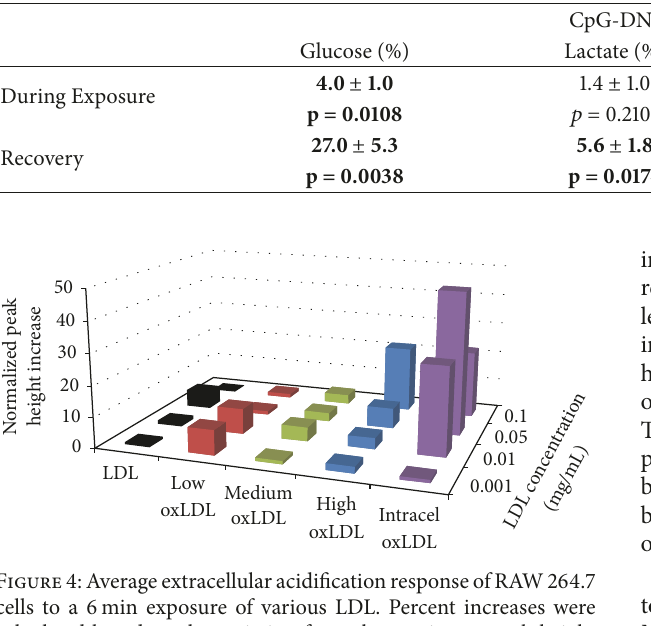
Table 5: Metabolic effects of CpG-DNA exposure on macrophages. Mean peak MAMP height changes and standard errors for each experimental condition during exposure and recovery are shown. All 𝑝 values are calculated based on peak height versus 10min average basal value prior to exposure. Terms in bold are representative of 𝑝 < 0.05 , indicating statistical significance.